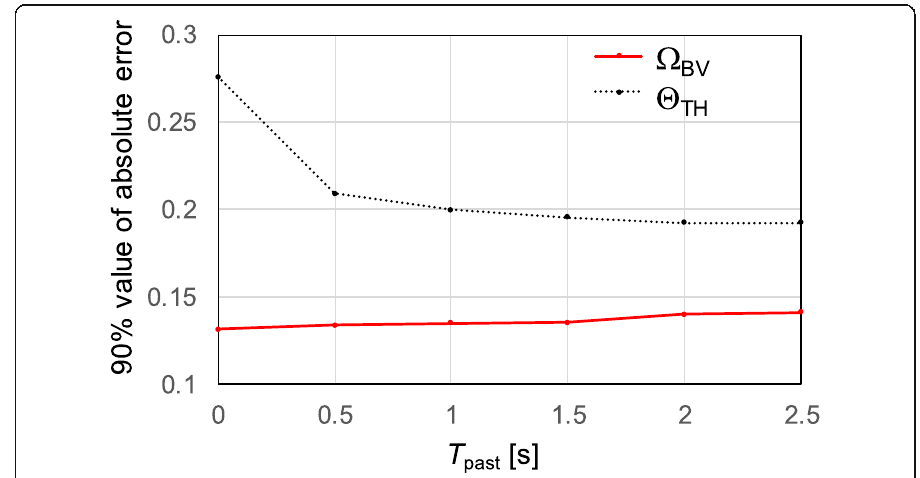
Fig. 12 The 90% values of prediction error CDF when past information was